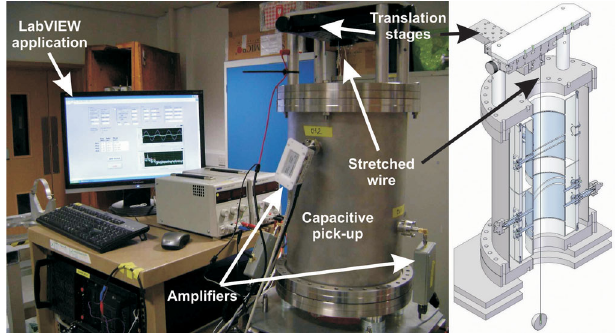
FIG. 23. Capacitive pickup test stand with a current-carrying wire.